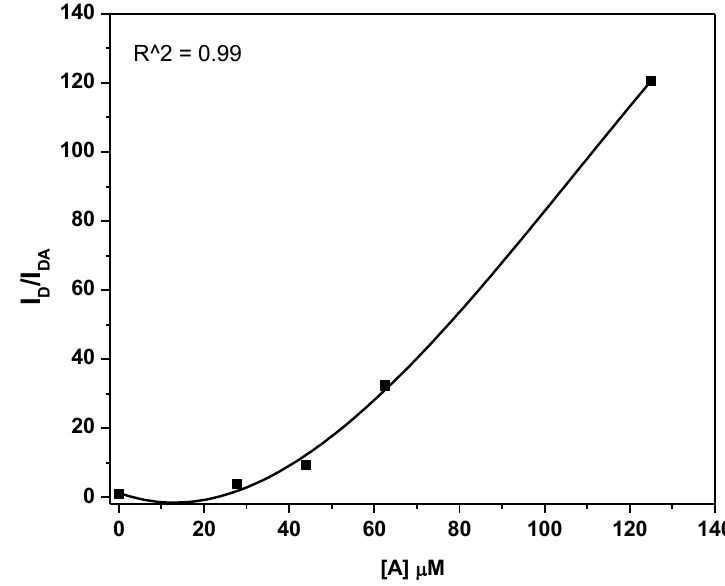
Figure 6. Linear Stern–Volmer plot for 0-D Cs 4 PbBr 6 / MEH-PPV hybrid thin